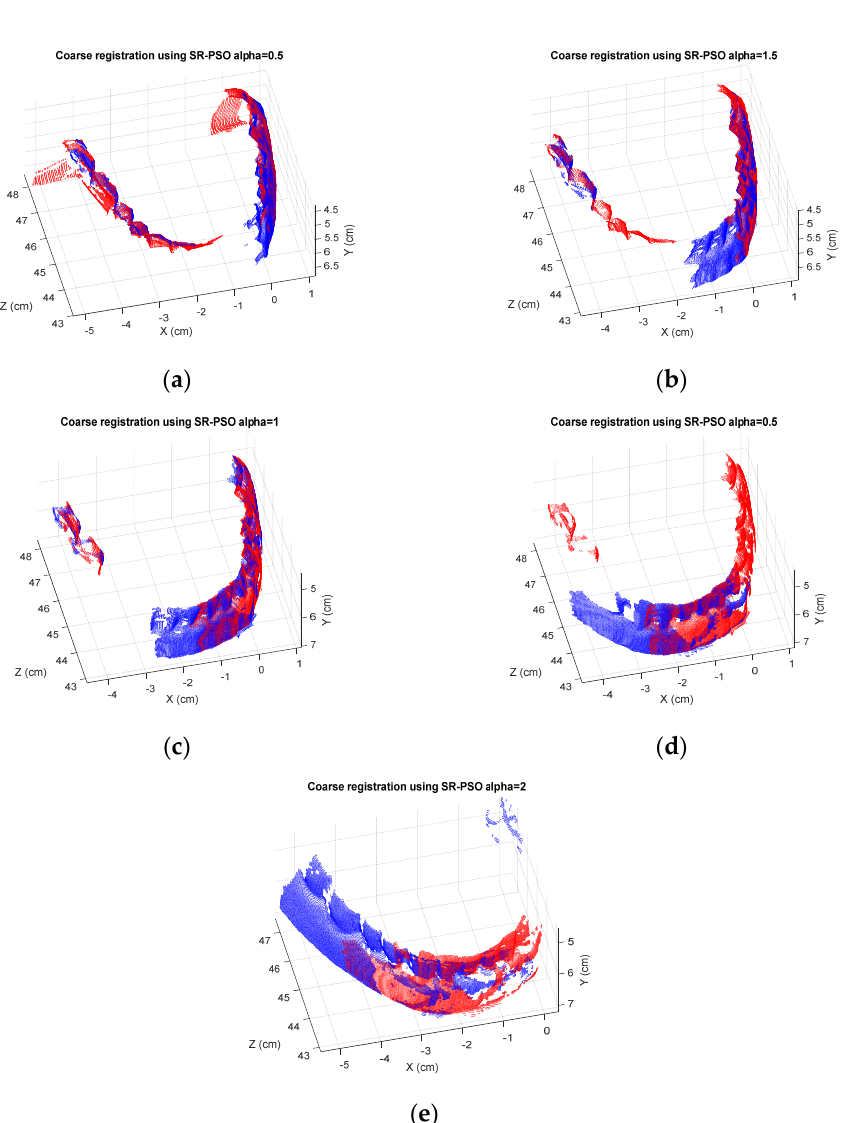
Figure 9. The best SR-PSO registration results for the pairs ( a ) 1 and 2; ( b ) 2 and 3; ( c ) 3 and 4; ( d ) 4 and 5; ( e ) 5 and 6 of the regular-tooth